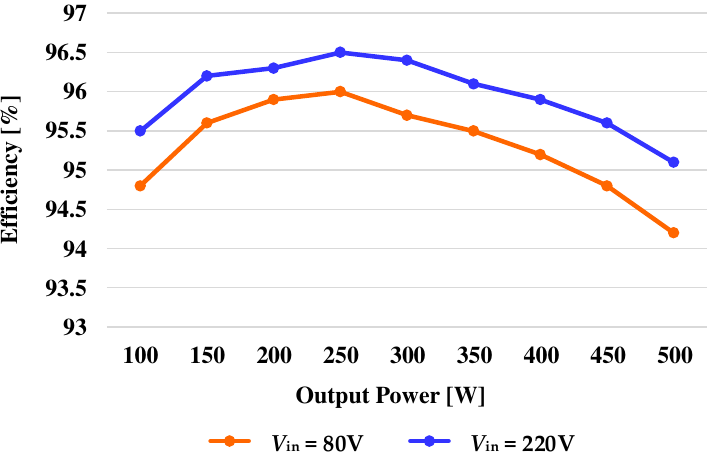
Figure 10. Measured experimental efficiency.